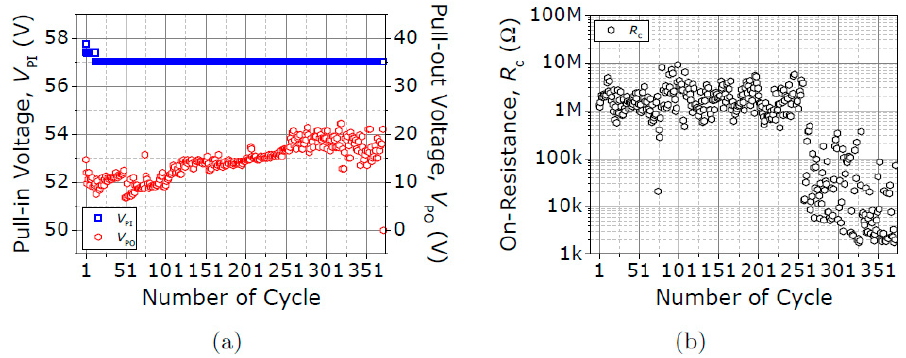
Figure 9. Evolution of ( a ) V PI , V PO and ( b ) R c over 355 switching cycles under vacuum conditions and V DS fixed at 3 V. Compliance current set over the measured current level.